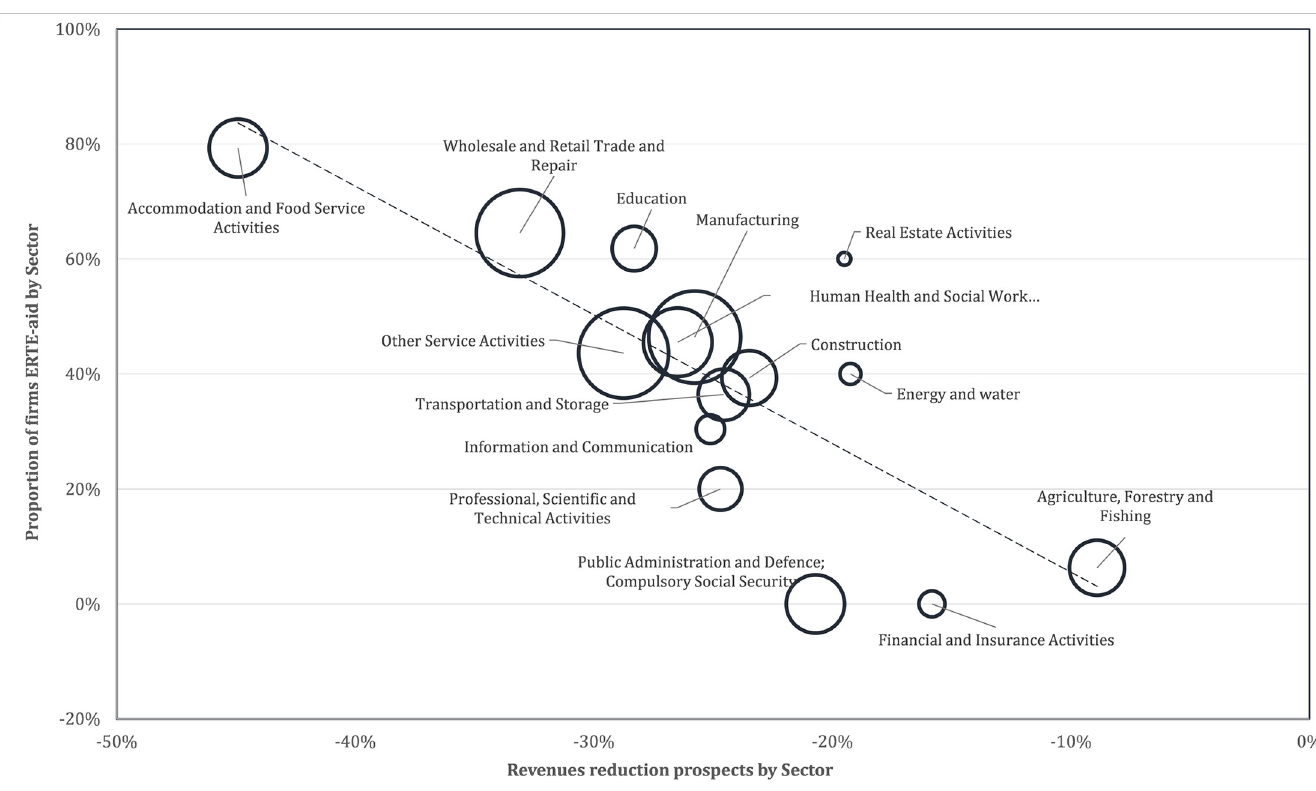
Fig 1. Proportion of firms with ERTE-aid and revenues reduction